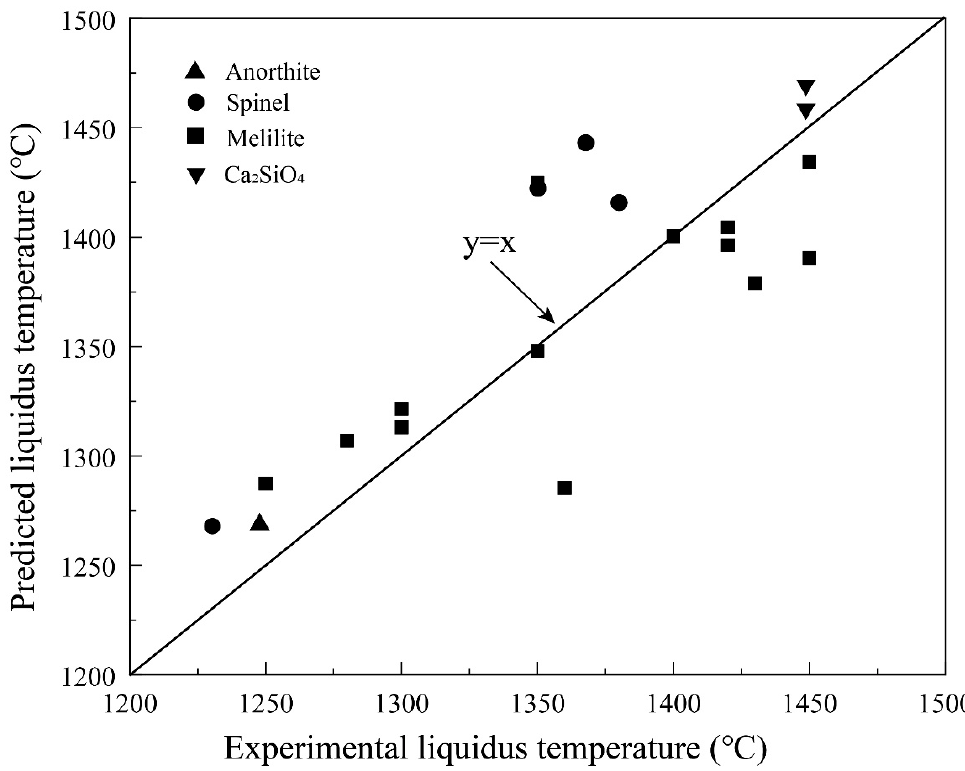
Figure 8. Comparison of the experimental results and FactSage predictions on primary phase and liquidus temperatures. All experimental liquidus are in the melilite primary phase field. The predicted primary phases are shown in the figure.